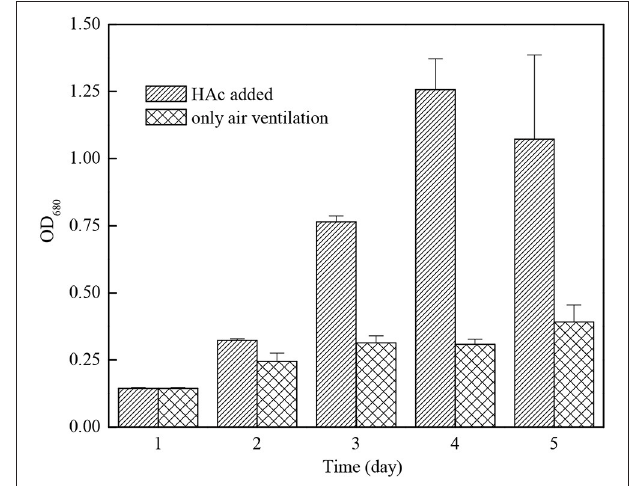
FIGURE 4 | The effects of different nitrogenous fertilizer on the growth of Chlorella zofingiensis G1.